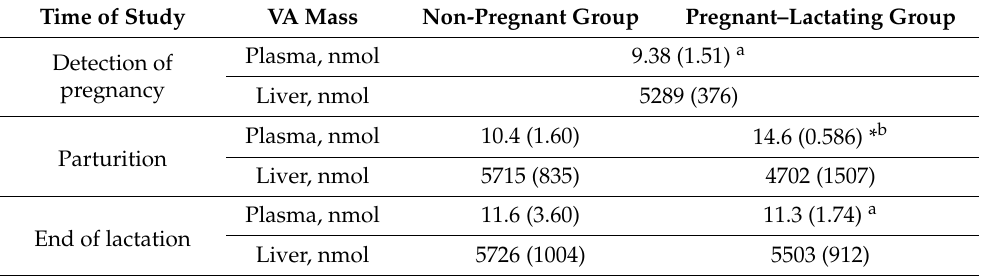
Table 2. Plasma and liver VA mass at different times for non-pregnant and pregnant–lactating group rats 1